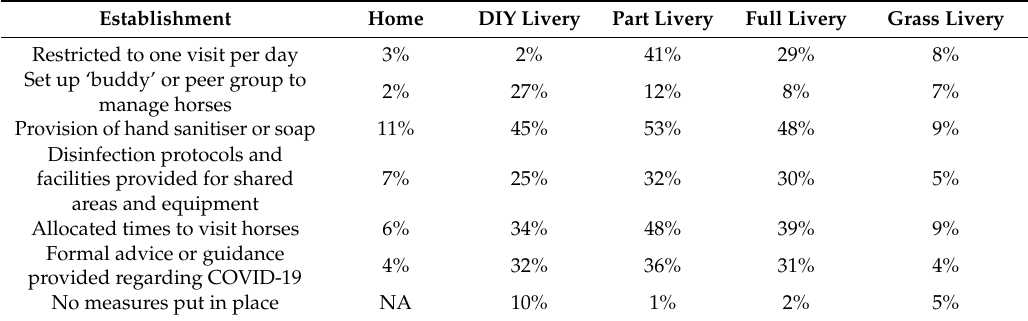
Table 1. Frequency of measures implemented in response to the coronavirus (SARS-CoV-2) pandemic across establishment types. Horse owners were asked to confirm if the establishment they kept their horse/s within in had provided the commonly recommended measures to reduce the cross-